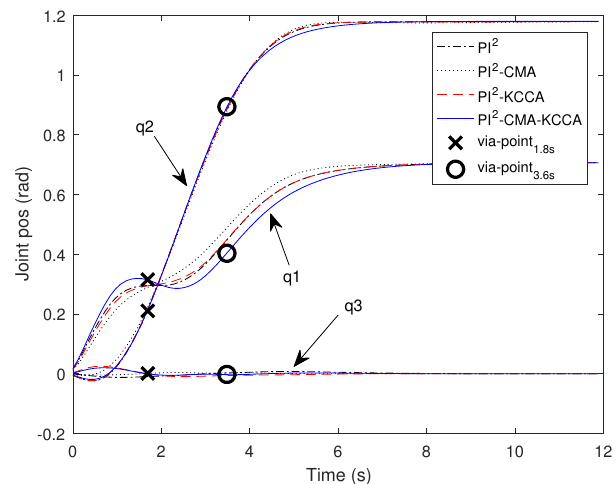
Figure 4. Cost of two via-point task.